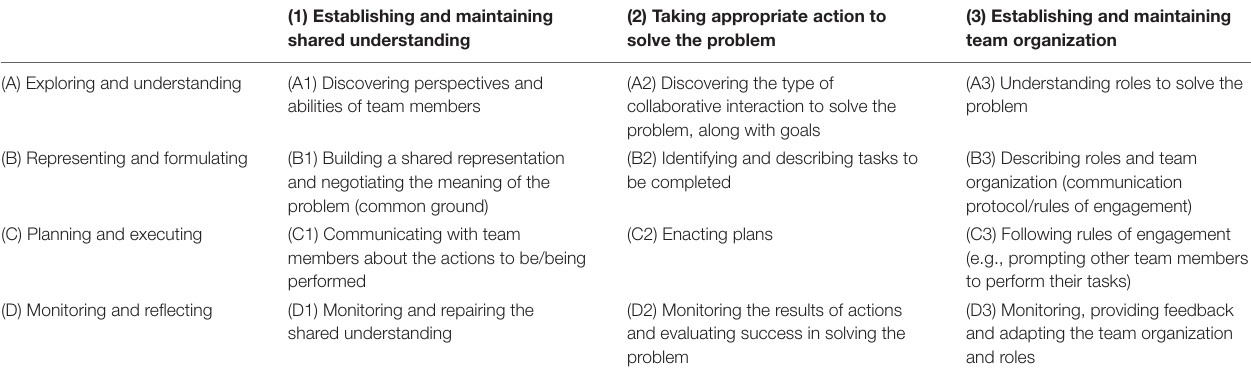
TABLE 1 | Matrix of CPS skills for PISA 2015